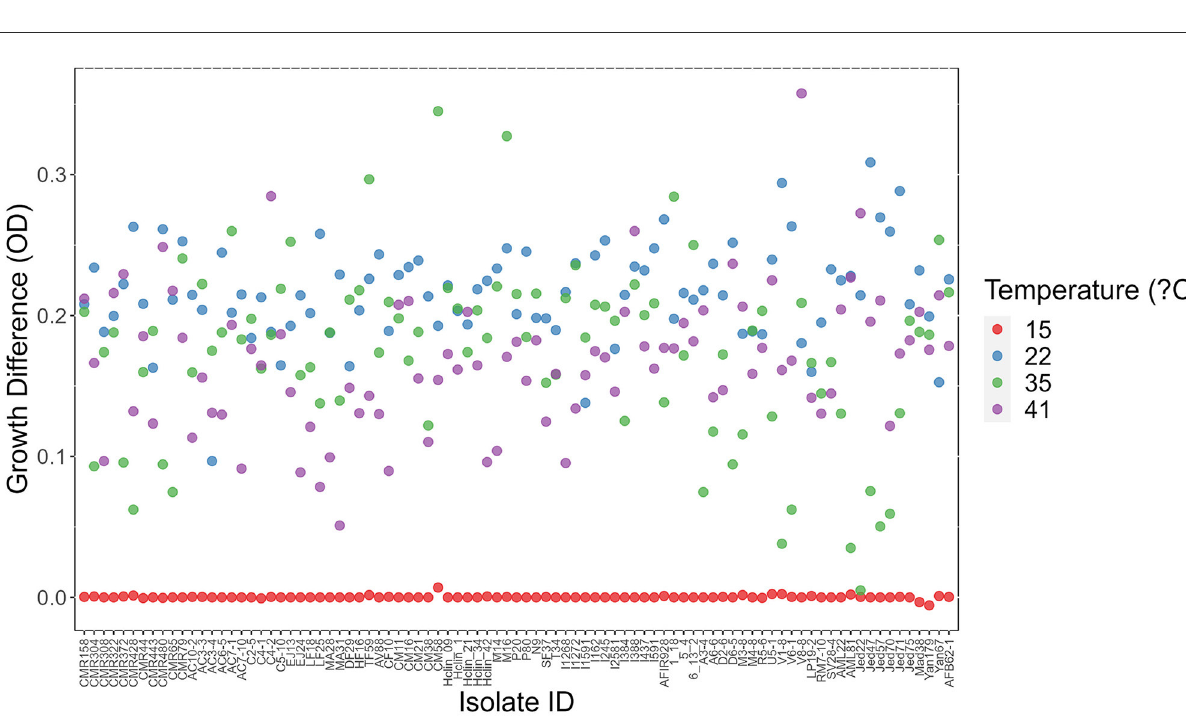
day 3 (Figure 5A). Indeed, upon removal of the 22 ◦ C data from the dataset, the three-day data showed no significant contribution to differences in CV at the whole sample level